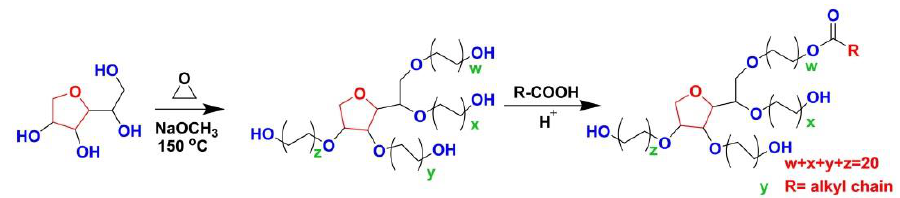
Figure 1. Schematic illustration for the synthesis of polysorbates from sorbitan.